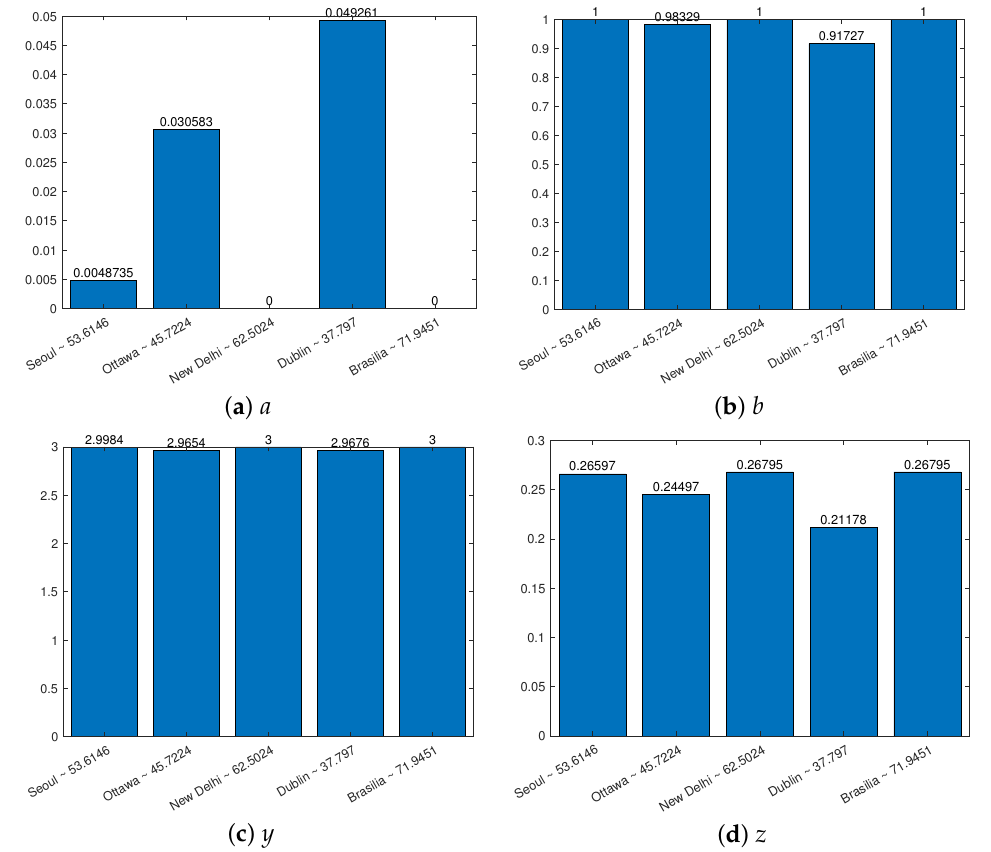
Figure 6. Weighted average values of parameters ( a , b , y , z ) with respect to each region in Table 1. Note that the number displayed after the city is the weighted average value of the south meridian altitude.